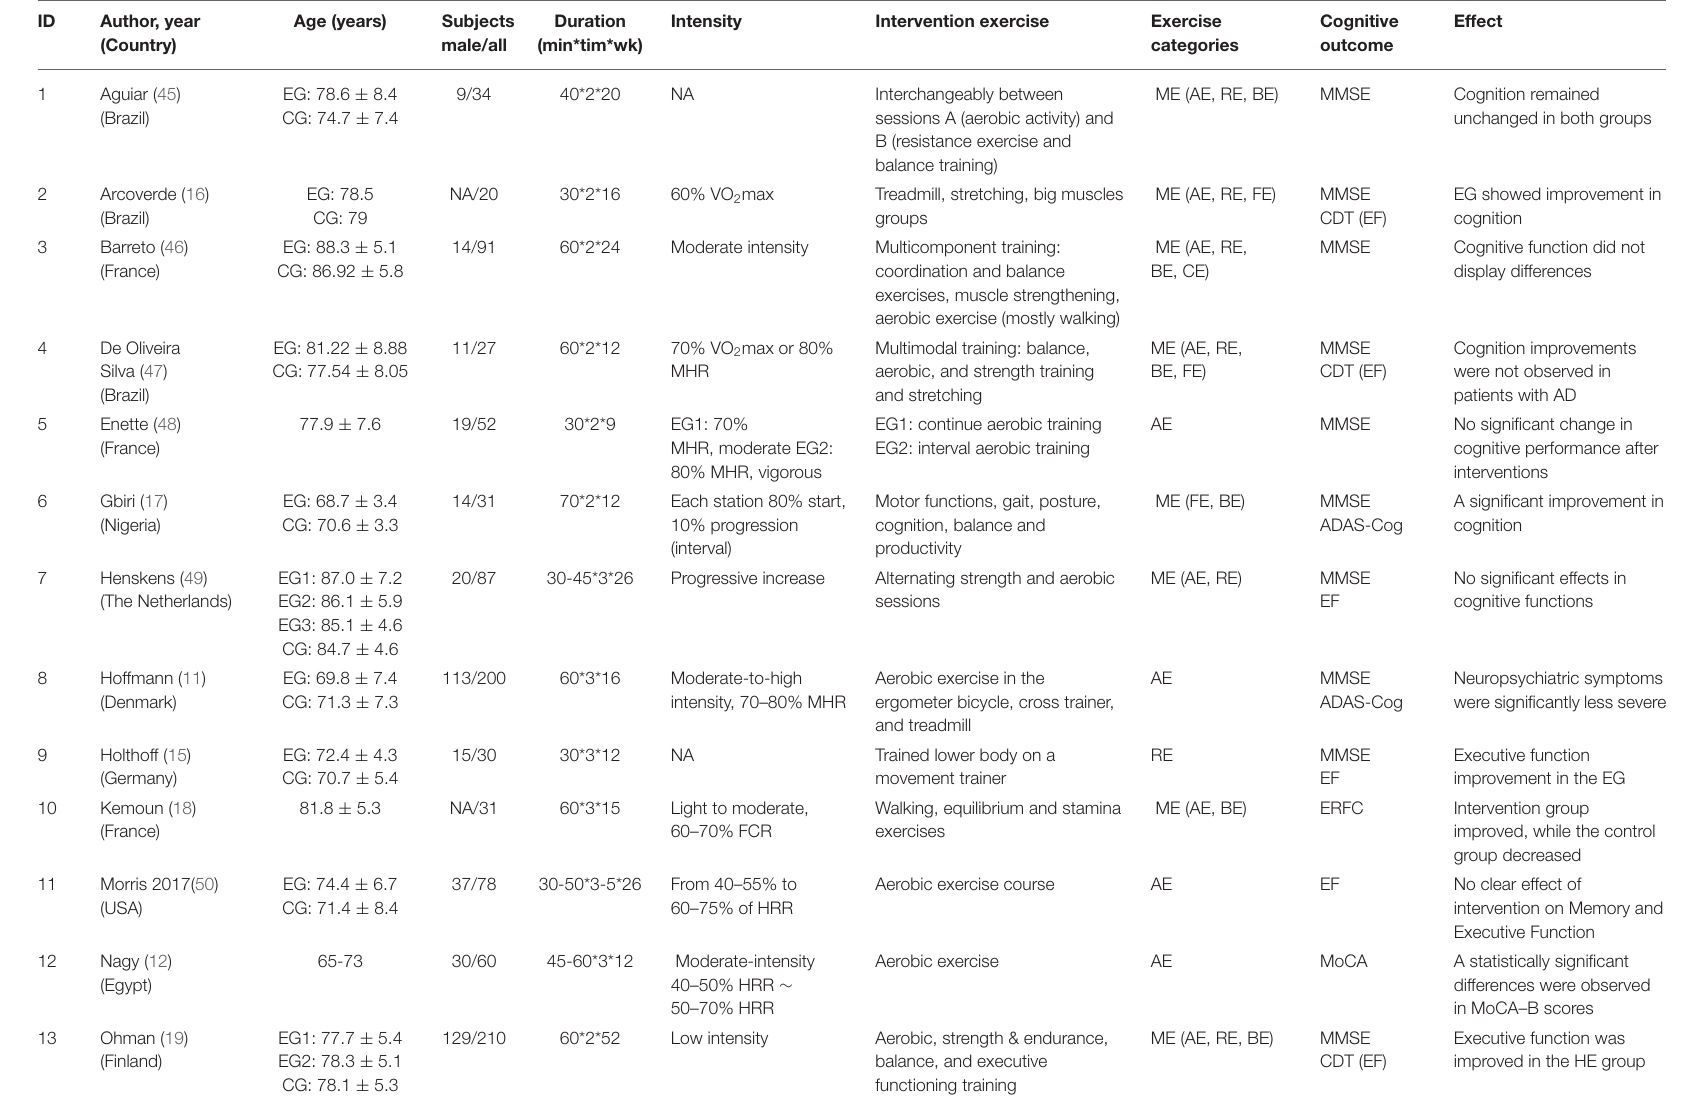
TABLE 1 | Characteristics of the inclusion